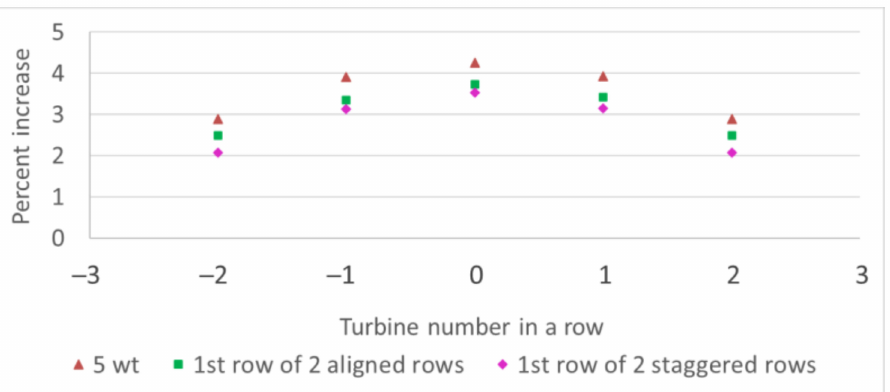
Figure 19. The speed increase in front of a wind turbine row compared to a row of one turbine. Staggered vs. aligned vs. no second